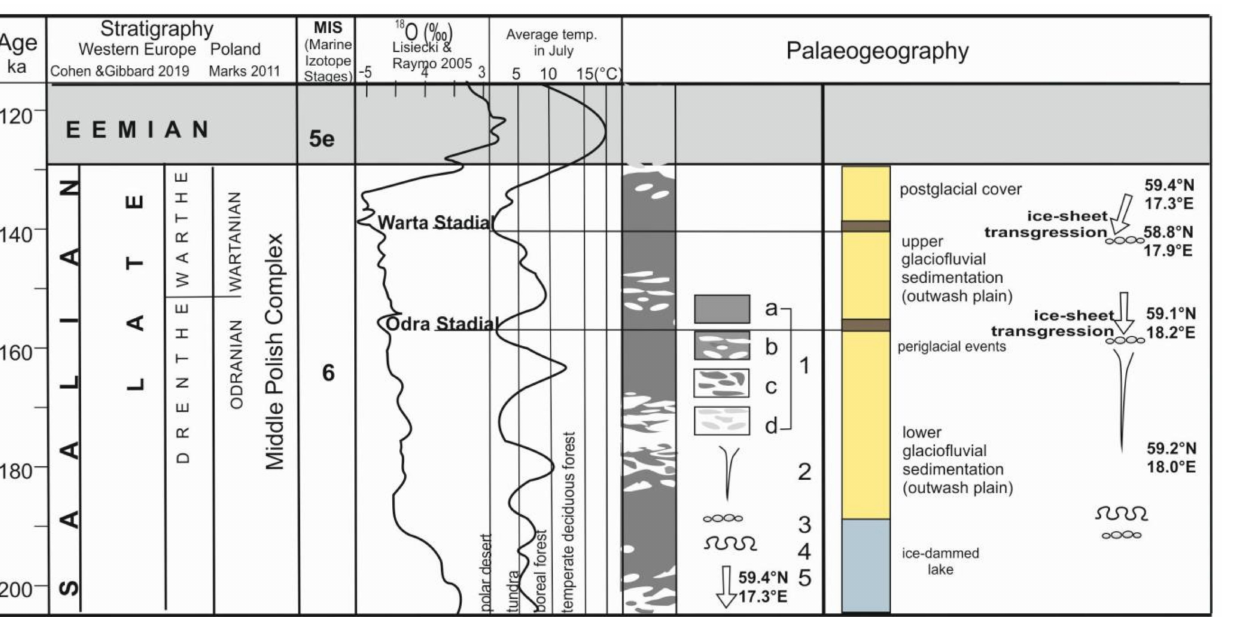
Figure 12. Formation of the glacial and glaciofluvial deposits in Łubienica-Superunki, central Poland, against the stratigra- phy and the chosen environmental features during Late Saalian in Europe Legend: 1—type of permafrost: a—continuous, b—discontinuous, c—sporadic, d—seasonal, 2—ice wedge, 3—erosional pavement, 4—direction of the ice sheet movement generated on the basis of complex petrographic analysis,